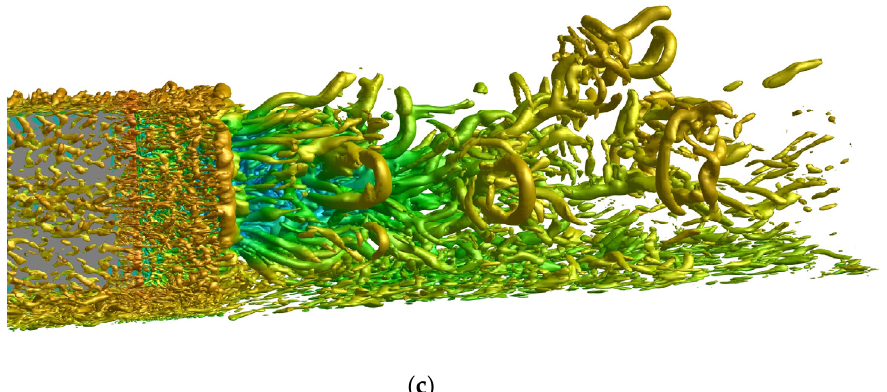
Figure 16. The normalized streamwise contour at the iso-surface Q = 300,000 s -2 with different actuator types. ( a ) A steady blowing jet; ( b ) a synthetic jet; ( c ) an unsteady jet.